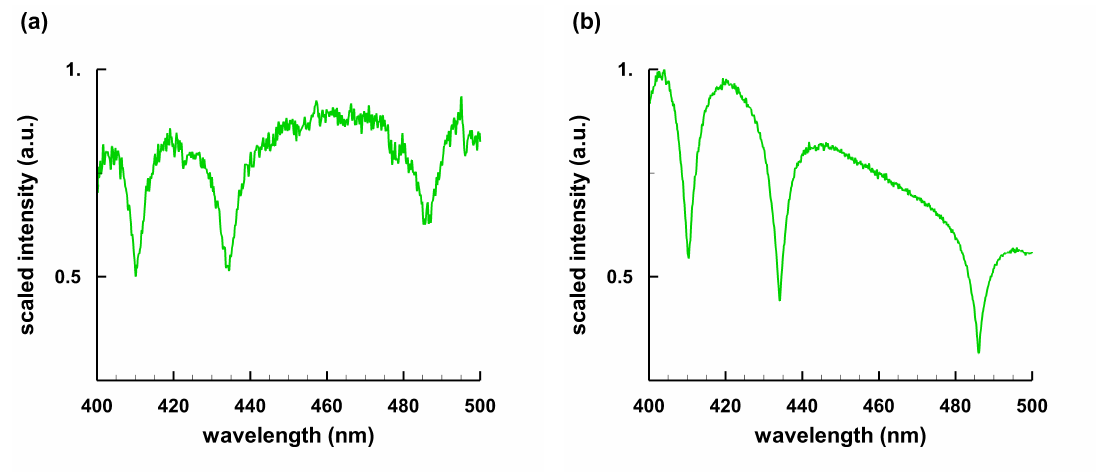
Figure 4. Astrophysical white dwarf spectra: ( a ) WD 1643+143 [55]; and ( b ) WD 1204+023 [5] or SDSS J120650 [57].